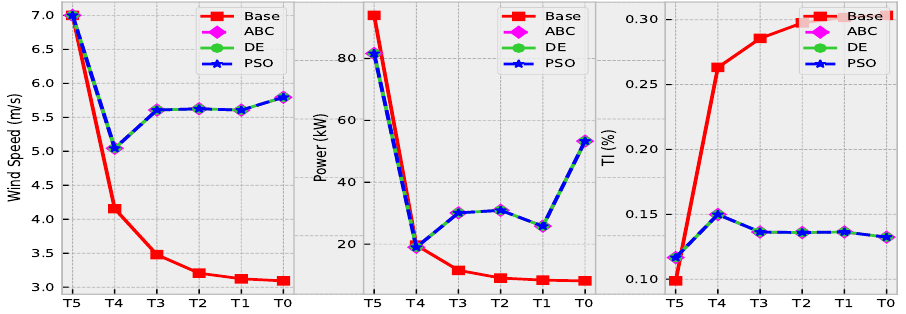
Figure 7. 4 D deployment distance at 7 m/s mean wind